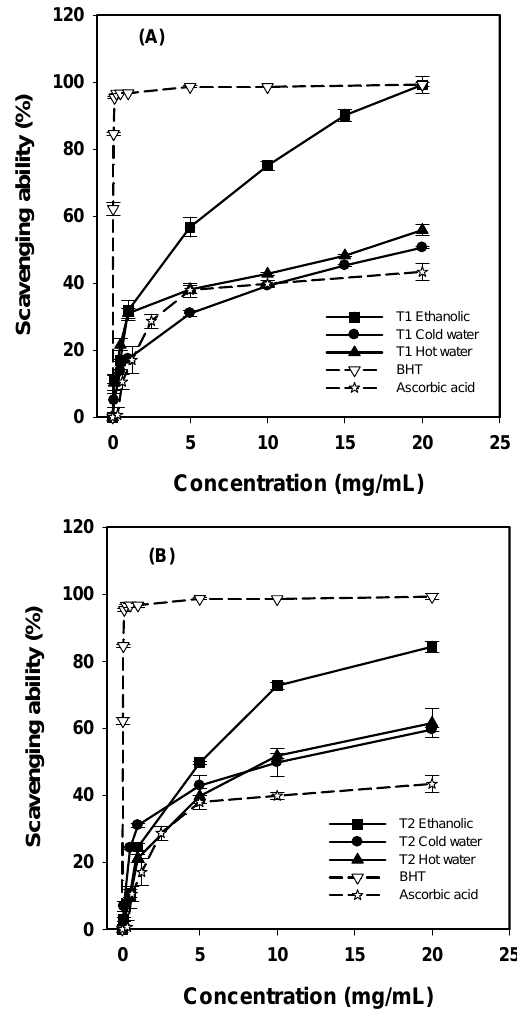
Figure 2. Scavenging ability of various extracts from G. frondosa T1 (A), and G. frondosa T2 (B) on DPPH radicals. Each value is expressed as mean ± S.D. (n =